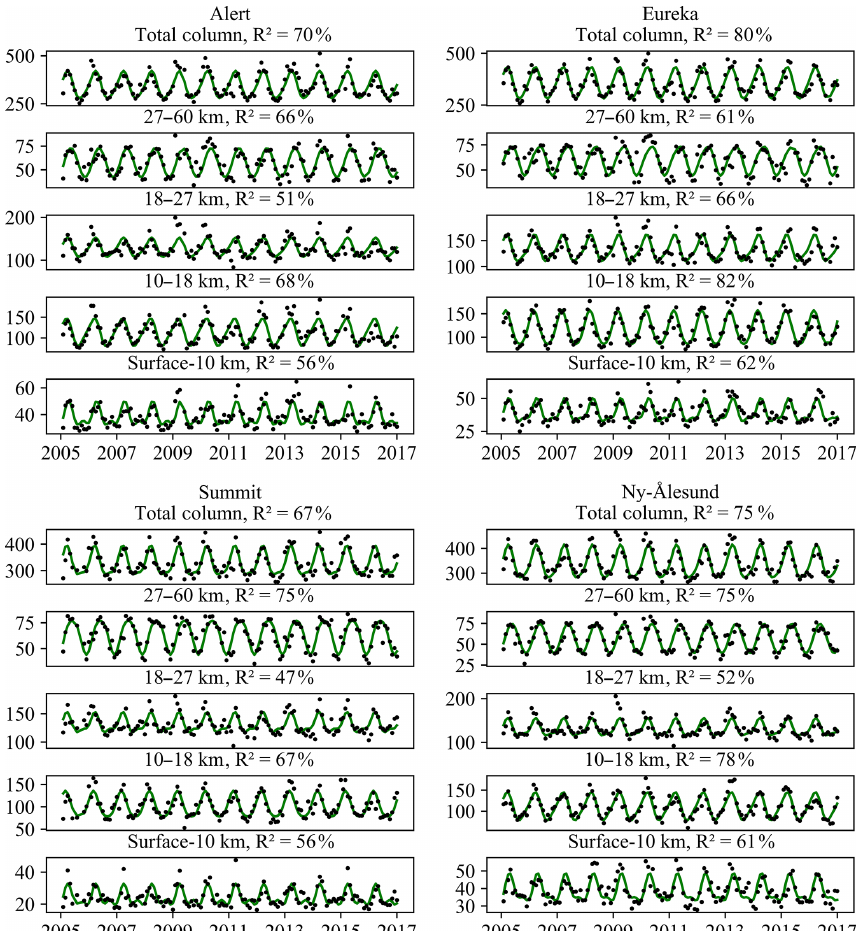
Figure 6. Time series of the total column ozone (top panels) and the partial column ozone (black dots) in four atmospheric layers (four bottom panels) from Alert, Eureka, Summit, and Ny-Ålesund. The fitted seasonal cycle is shown as the green curves. The coefficient of determination ( R 2 ) for each seasonal fit is shown in the title for each